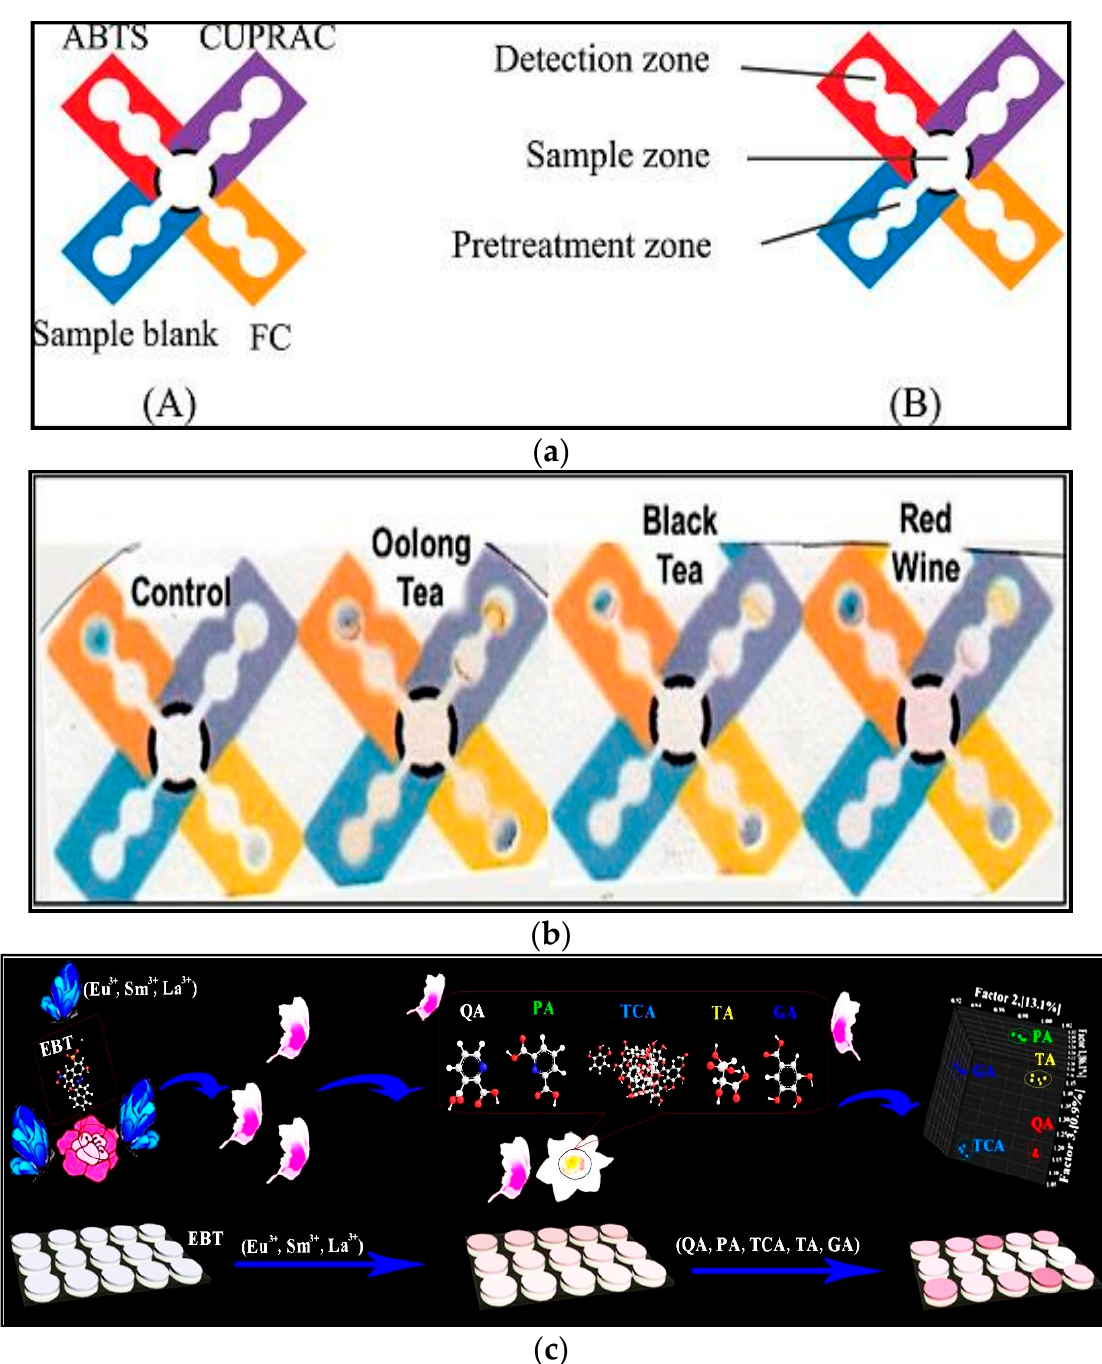
Figure 2. ( a ) Typical PADs for assessment of antioxidant activity and whole phenolic content. ( A ) The zones utilized for ABTS, CUPRAC, FC and sample blank. ( B ) The sample zone, pretreatment zones and recognition zones on the devices. Reprinted with permission from [15]; ( b ) Paper-based devices for identification of antioxidant activity and whole phenolic content of the samples containing Oolong tea, black tea and red wine compared to the control. Reprinted with permission from [15]; ( c ). A colorimetric sensor array based on three different lanthanide ions as sensing receptors for antioxidants analysis. Reprinted with permission from [51].